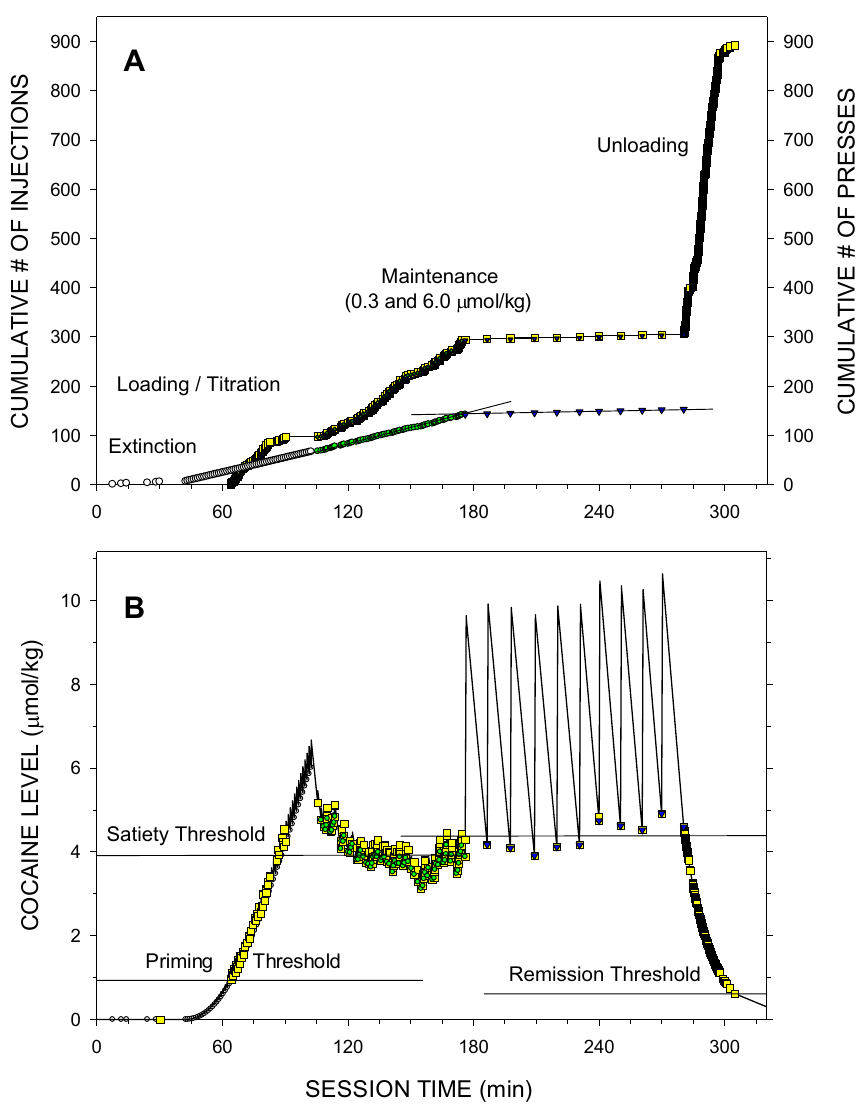
Figure 4. Cumulative records of events ( A ) and the calculated levels of cocaine at the time of each event ( B ) during a representative Post-PR FR1 session. Lines and symbols as in Fig. 1. ( A ) Open circles represent programmed priming injections of escalating doses of cocaine (doses increased from zero to 0.655 μmol/ kg). Both the inter-press and inter-injection intervals were very regular during the FR1 maintenance phase as demonstrated by the linear regression lines. The mean ± SEM inter-injection intervals were 56.4 ± 4.5 s and 626.2 ± 26.0 s at unit doses of 0.3 µmol/kg (green circle) and 6 µmol/kg (blue inverted triangle), respectively. The last inter press interval was longer than 60 min. The unloading phase duration was 24.1 min and the terminal local rate of lever-pressing was LR term = 24.27 presses/min. ( B ) Horizontal lines represent mean ± SEM D ST = 3.89 ± 0.04 µmol/kg and D ST = 4.38 ± 0.10 µmol/kg at unit doses of 0.3 (green circle) and 6.0 (blue inverted triangle) µmol/kg, respectively, and the D PT = 0.97 µmol/kg and the D RT = 0.62